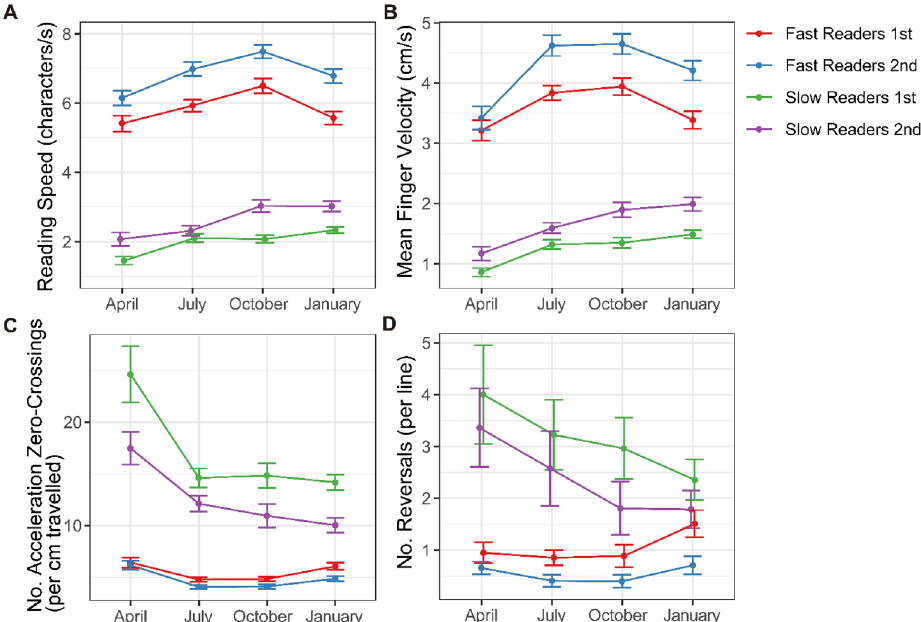
Figure 2. ( A ) Mean reading speed in characters per second, ( B ) mean finger velocity in cm/s, ( C ) number of acceleration zero-crossings per cm travelled, and ( D ) number of reversals per line as a function of month (April, July, October 2019, and January 2020), repetition (1st reading and 2nd reading for each month’s recording session), and group (fast readers with more than three years of braille experience and slow readers with 2 years or less experience). Each variable is computed for each line of the braille passage. The braille passage consists of 11 to 14 lines, and the lines comprising of more than 15 braille characters contributed to the analysis (Table S1). Error bars represent ± 1 standard error of the mean. Figure prepared in R software (version 4.0.2, R Core Team, 2020, Vienna, Austria) 43